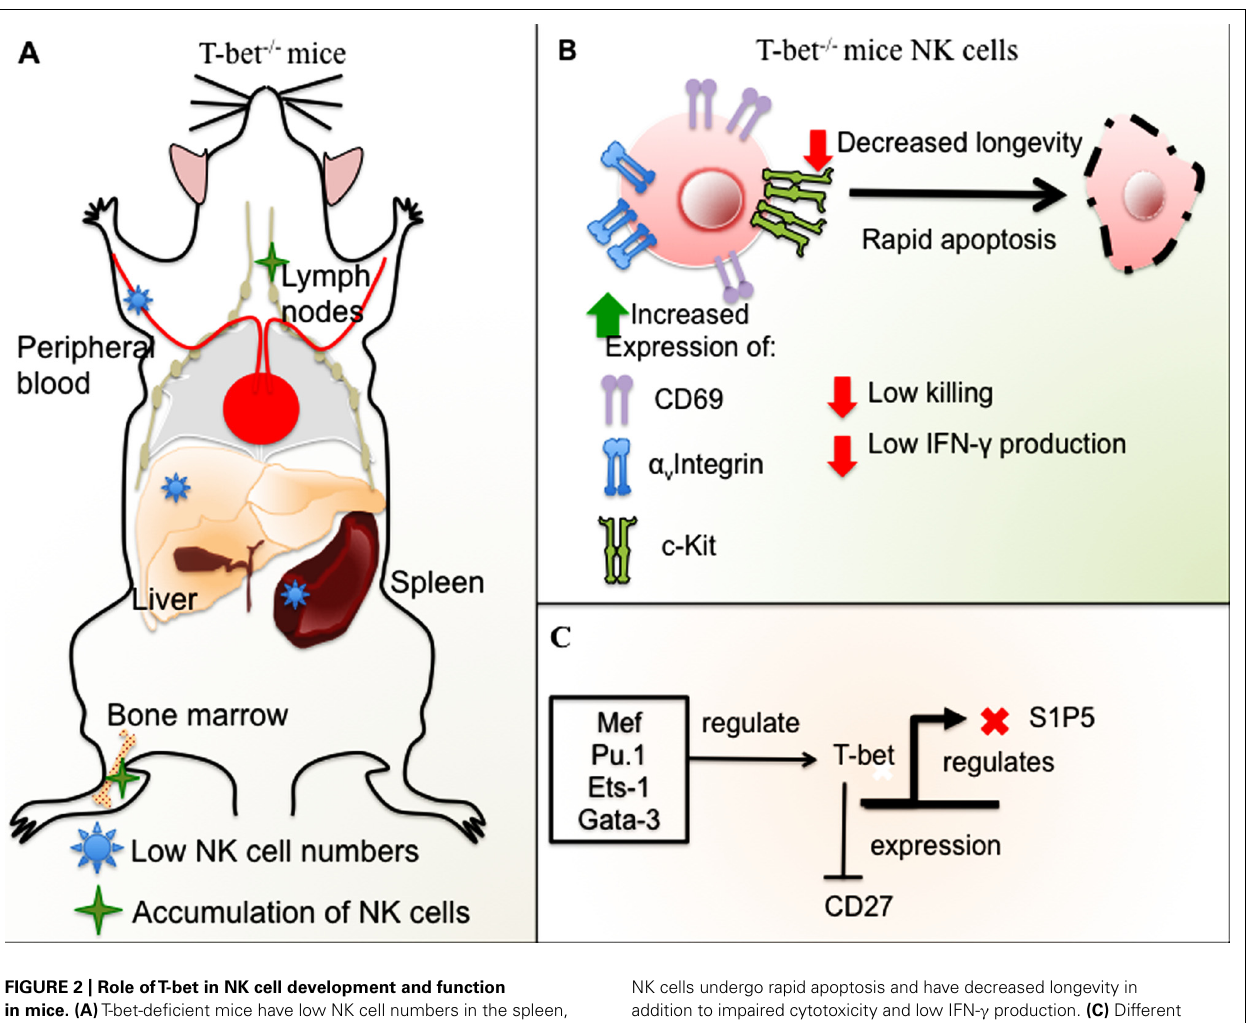
FIGURE 2 | Role ofT-bet in NK cell development and function in mice. (A) T-bet-deficient mice have low NK cell numbers in the spleen, liver, and peripheral blood with accumulation of NK cells in LNs and BM. (B) NK cells fromT-bet-deficient mice have an immature phenotype, expression of α v integrin and ckit, and high levels of CD69.T-bet − /